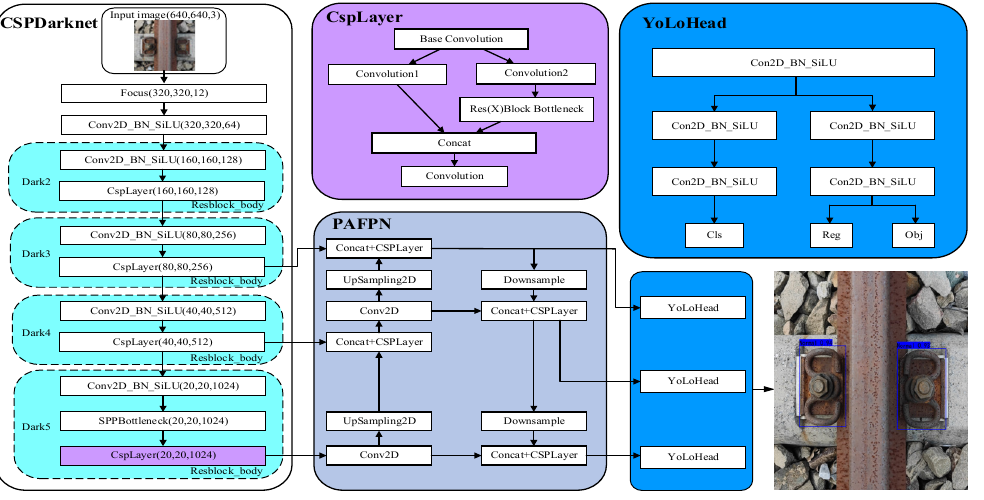
Figure 3. YoLoX-Nano neural network model. Backbone: A focus module (as shown in Figure 4) is used to classify the feature point information and stack them on the channel.